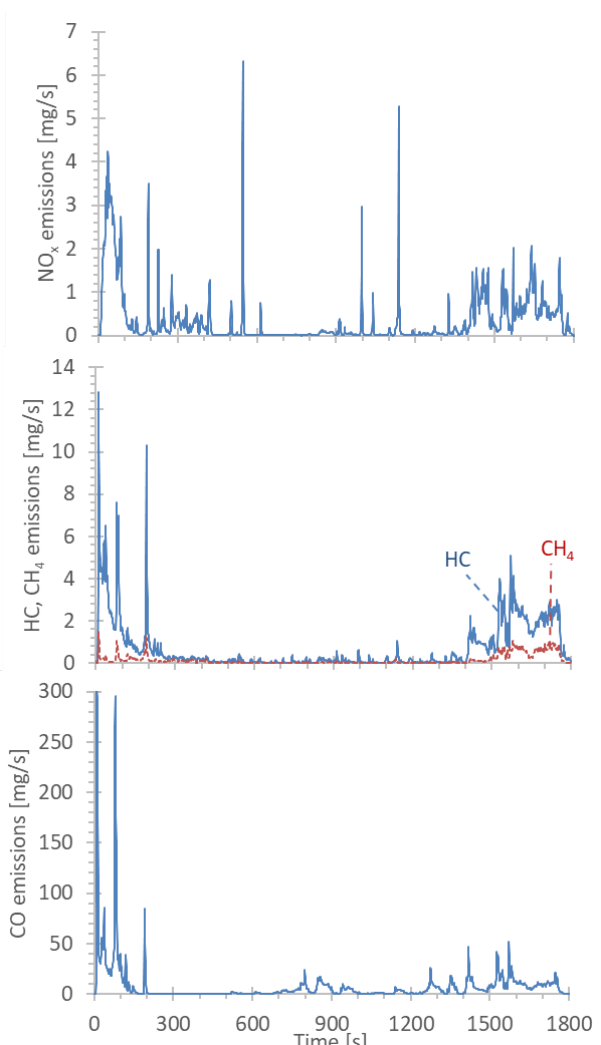
Fig. 3. Real time emissions of NO x (upper panel), HC and CH 4 (middle panel) and CO (lower panel)